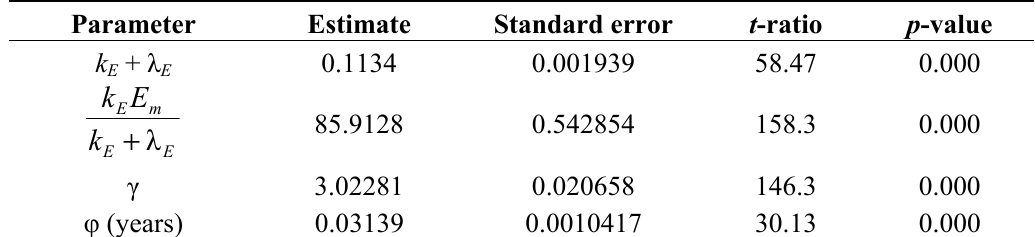
Table 2. Non-linear least-squares estimates of the price